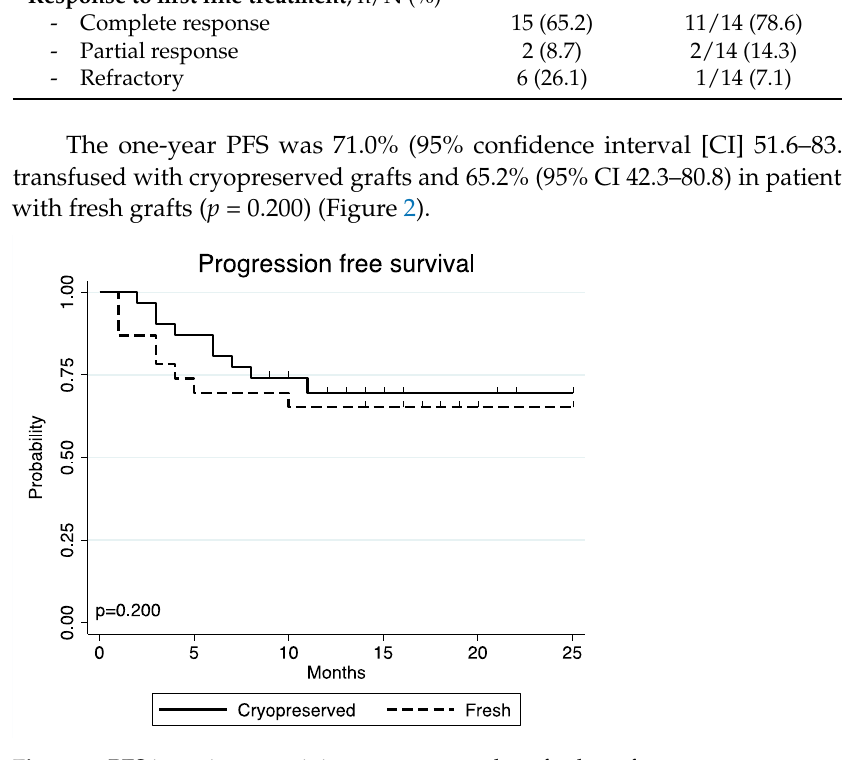
Figure 1. Cumulative incidence of neutrophil ( A ) and platelet ( B ) engraftment in Cryo and Fresh groups.